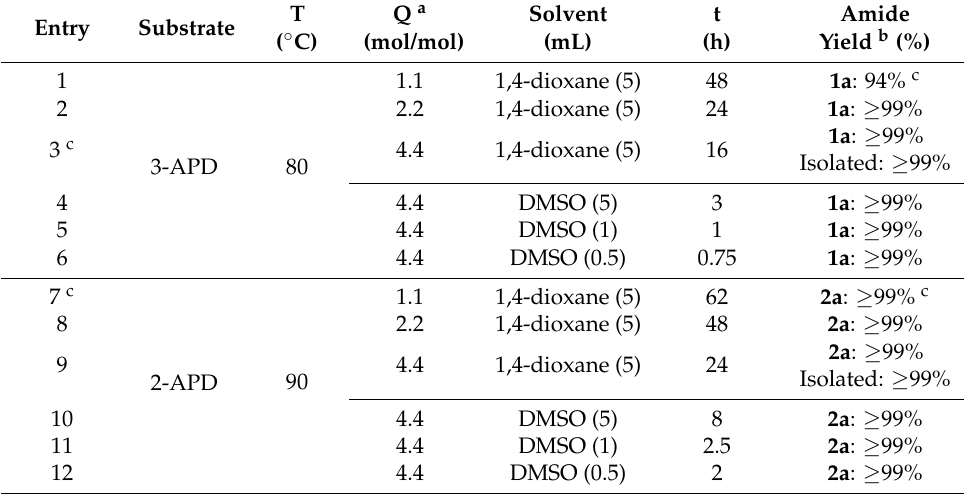
Table 1. The iPAc-mediated selective N-N-acetylation of 3- and 2-APD